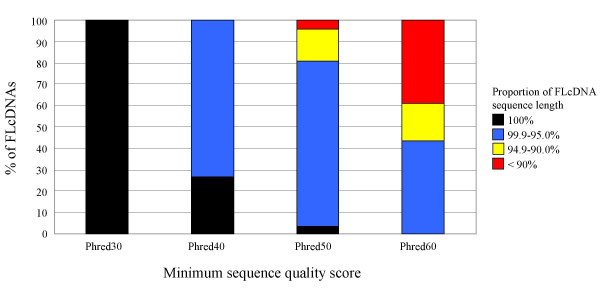
Validation of sequence quality of FLcDNAs. Sequence accuracy was measured as the percentage of the 4,664 FLcDNAs which, with 100%, 95.0–99.9%, 90.0–94.9% or < 90.0% of their sequence length, exceeded Phred30, Phred40, Phred50 or Phred60 sequence quality thresholds. All 4,664 FLcDNAs exceeded the Phred30 quality thresholds (calculated as less than 1 error in 103 sequenced nucleotides) over 100% of their sequence length. Even at the threshold level of Phred60 (calculated as less than 1 error in 106 sequenced nucleotides) the majority (61.2%) of the FLcDNA sequences met this very high sequence quality score over > 90.0% of their length.